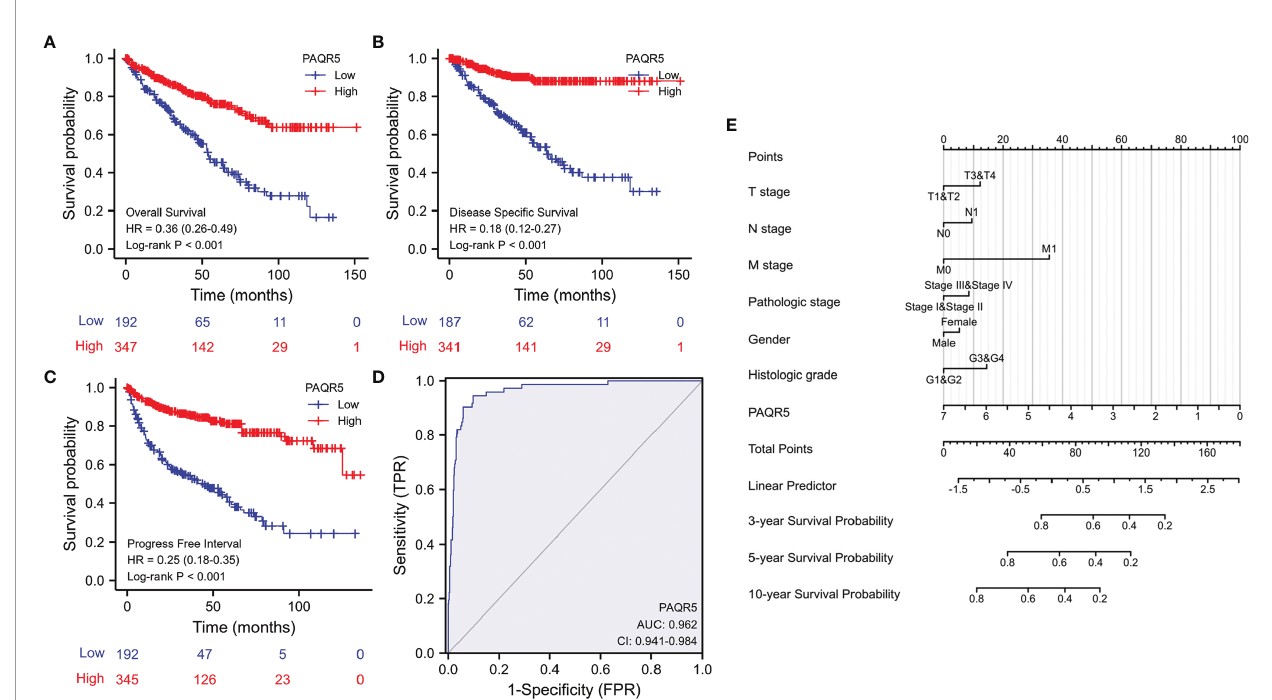
FIGURE 4 | PAQR5 downregulation is associated with poor survival outcomes in ccRCC patients. (A – C) Kaplan-Meier survival analysis was conducted in ccRCC patients using the RNAseq data from the TCGA project. Patients were strati fi ed using the minimum p-value approach (26). (D) A ROC curve analysis was conducted for overall survival prediction using PAQR5 expression levels in ccRCC patients. (E) A nomograph for survival prediction was constructed using the PAQR5 expression levels and the clinicopathological parameters. The nomograph is a calculator tool to predict patient survival rate using clinicopathological data plus the expression levels of biomarker gene. For instance, a male patient had a Grade-1 RCC of T1/N0/M0 at Stage-1, and his PAQR5 expression level was at 3.5. All these parameters will get their nomograph ’ s points (at the top line). The sum of these points will used to fi nd a linear predictor value, which is applied to fi nd the survival rate. In this case, his total point is 90, then his linear predictor is about 0.75, which indicates his survival rate for 3-year at 60%, 5- year at 40%, and 10-year at 20%.